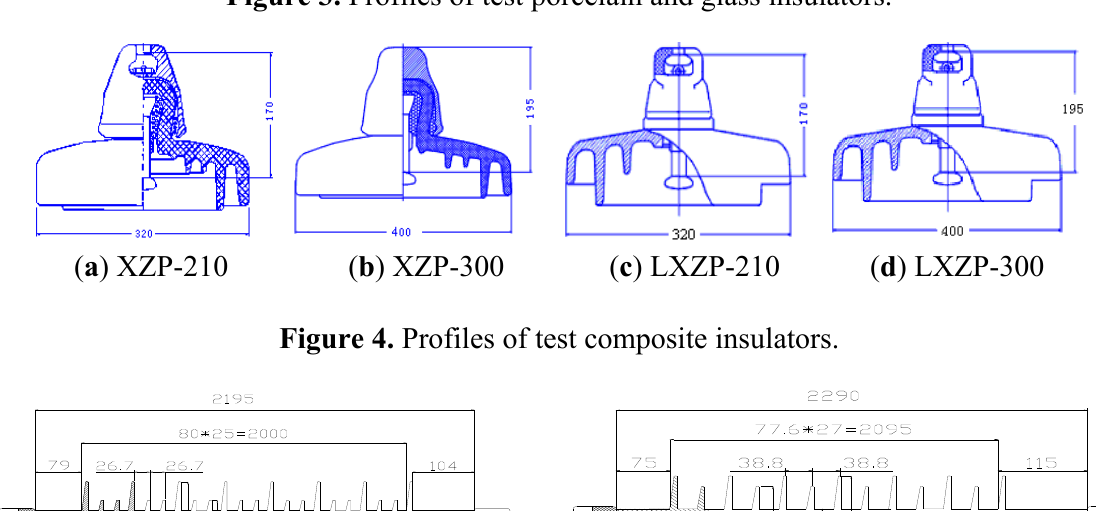
Figure 3. Profiles of test porcelain and glass insulators.